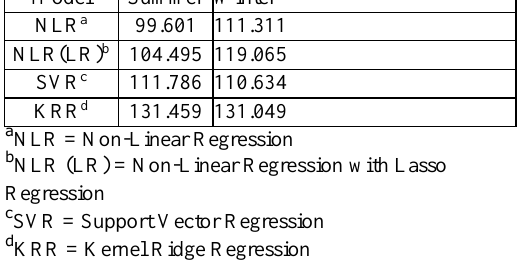
Figure 19. Results (RMSE) of Environmental Data Models